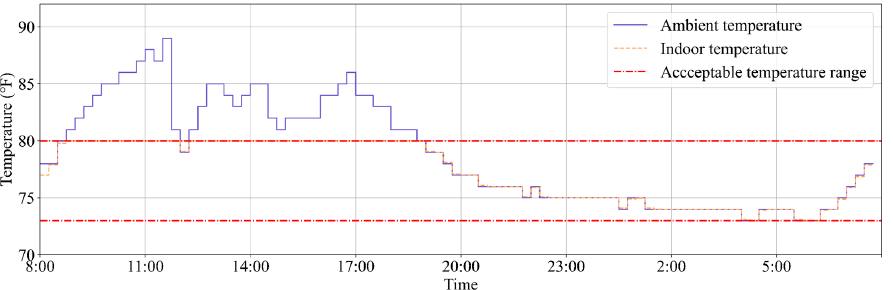
Figure 7. Scheduling results of the air conditioning considering thermal comfort of the residents.